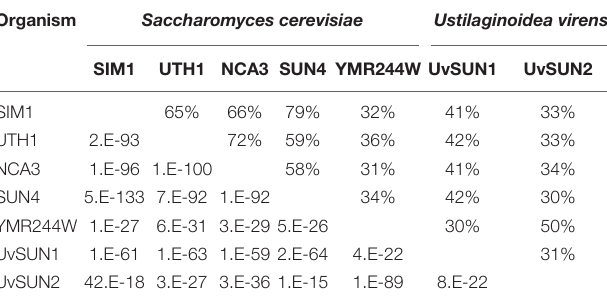
TABLE 1 | Amino acid sequence identity and expect value of UvSUN1 and UvSUN2 to S. cerevisiae proteins in the SUN family.